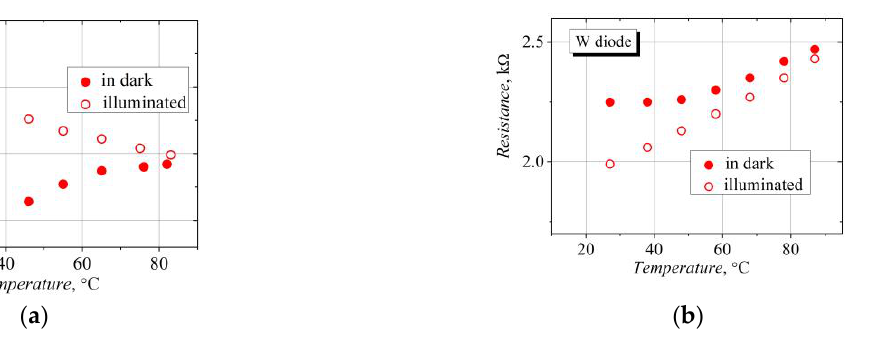
Figure 8. The relaxation of the voltage detected across the W-diode after it was affected by a strong microwave electric field ( a ) and after its illumination with visible light ( b ). Lines indicate approximation via exponential functions.